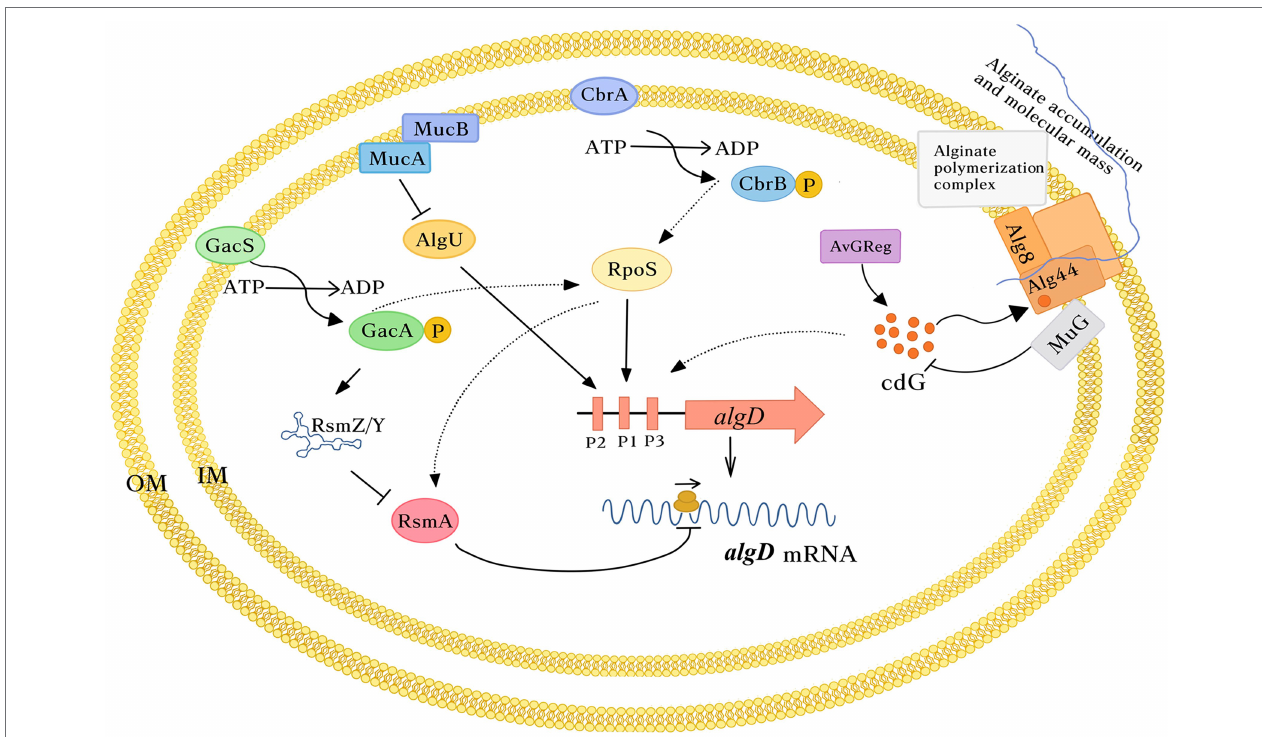
FIGURE 2 | Schematic representation of algD regulation in Azotobacter vinelandii . Transcription of algD starts from three promoters that depends on the stress response sigma factor AlgU and the stationary phase sigma factor RpoS. The two-component systems CbrA/B and GacS/A exert a positive effect on RpoS. algD translation is under the control of the GacS/A-Rsm system. GacA activates transcription of a family of sRNAs of the RsmY/Z family counteracting RsmA activity. This last protein directly binds algD mRNA blocking translation. The c-di-GMP control module, composed of the DGC AvGReg and the PDE MucG, modulates la pool of this second messenger presumably in the vicinity to the Alg8-Alg44 polymerase complex, regulating the amount and the MM of the polymer produced. The c-di- GMP levels positively influence algD transcription. For simplicity, only one algD transcriptional unit is shown. In the periplasmic scaffold, responsible for alginate transport and secretion, only the polymerase complex Alg8-44 is shown. Dashed arrows, indirect